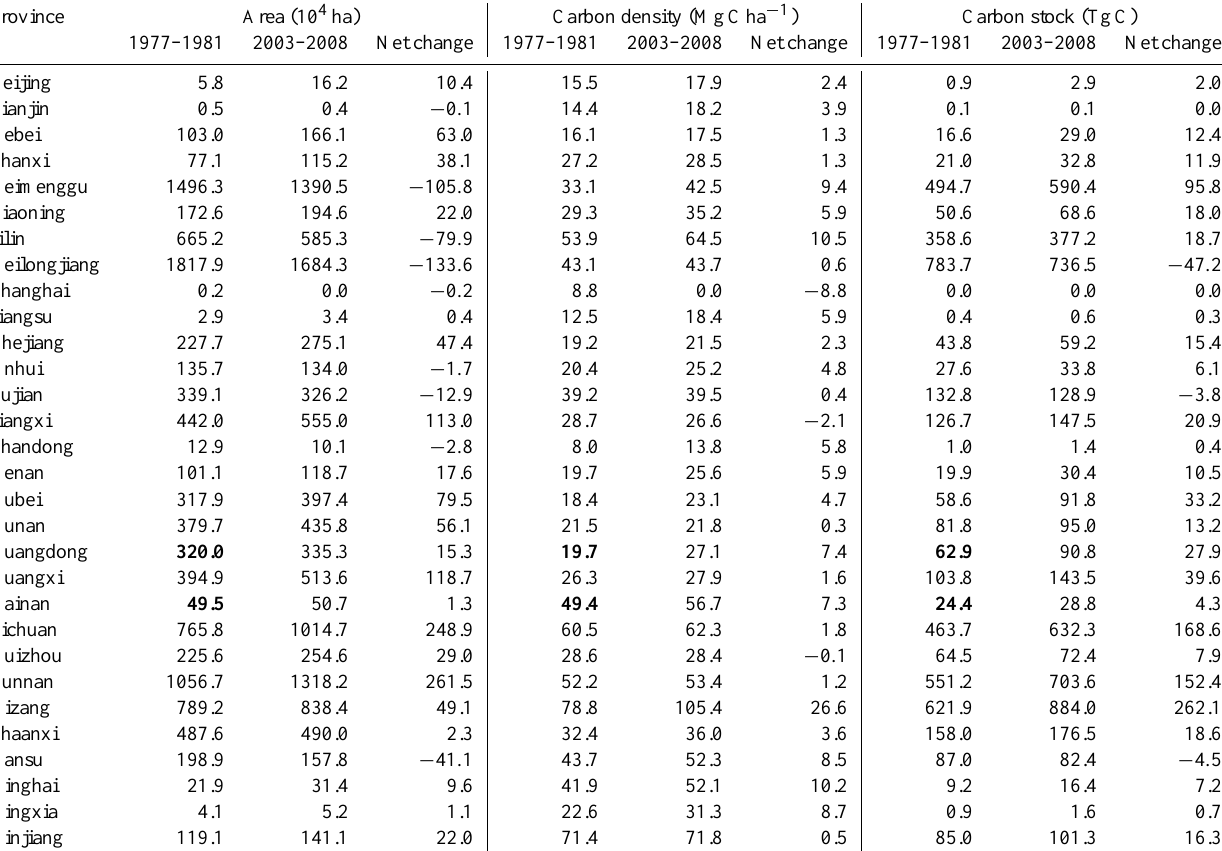
Table D1. Changes in forest area, carbon density, and carbon stock for natural forests in provinces of China for the period 1977–2008.